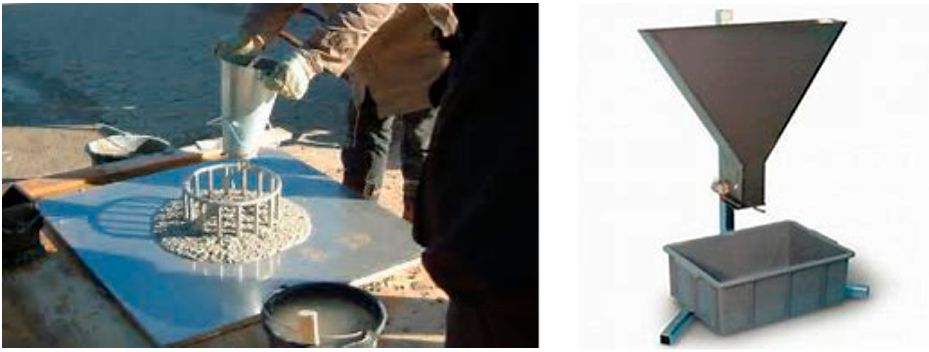
Figure 1. Standard J-Ring and V-Funnel test apparatuses.